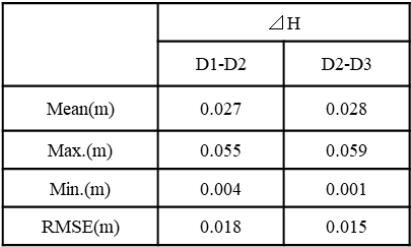
Table 5. Elevation accuracy between adjacent flying courses